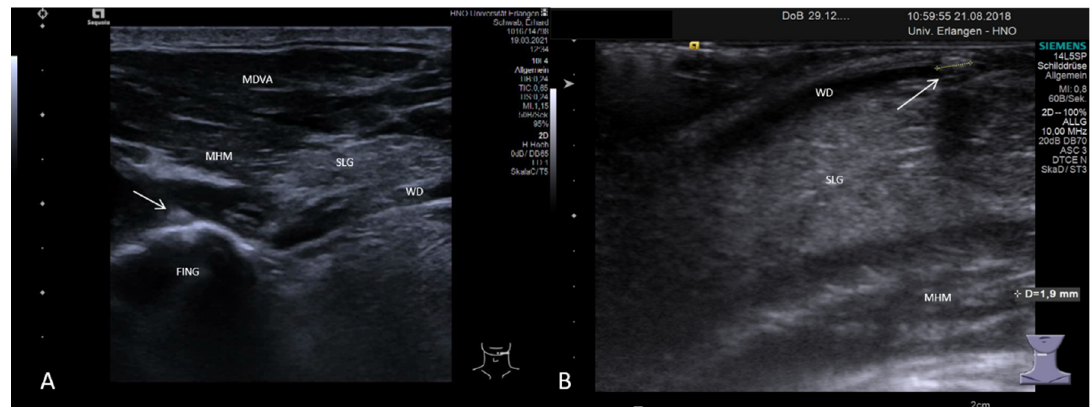
Figure 4. Two modifications of US application to overcome the extinction of the sound waves by the mandible in order to diagnose small sialoliths in the distal Wharton’s duct. A small stone is depicted using transcervical US and “sonopalpation” ( A ). The small stone (white arrow) is moved out of the shadow of the mandible with the palpating finger. Application of transoral US is shown in ( B ). A small stone (white arrow, size 1.9 mm, dotted line) near the papilla is shown after positioning of a small transducer onto the mucosa of the floor of the mouth. Abbreviations: SLG, sublingual gland; MHM, mylohyoid muscle; DMVA, digastric muscle venter anterior; WD, Wharton ´ s duct; FING, palpating finger.